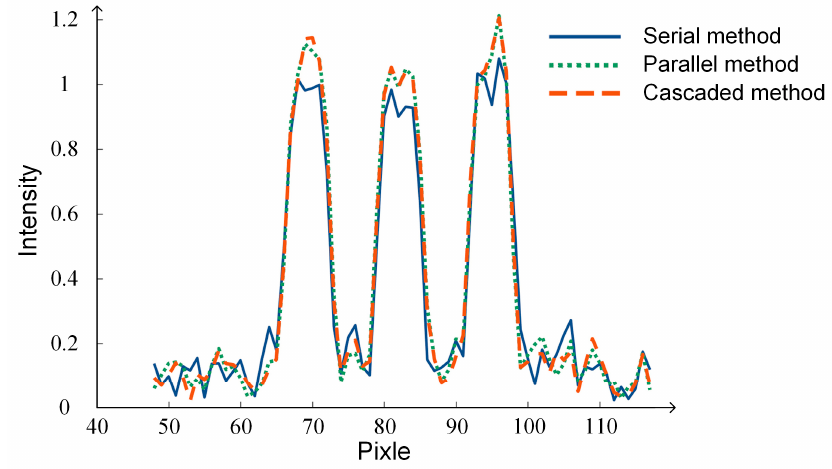
Figure 9. Cross-sections of the white lines marked in Figures 8a–c.